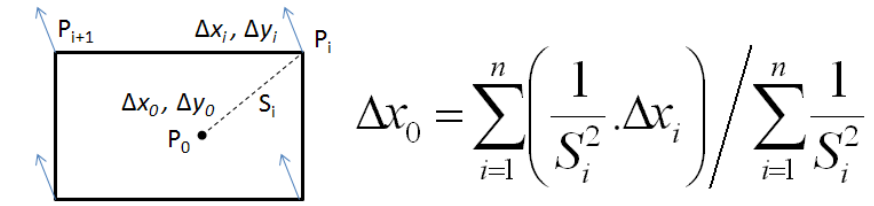
Figure 9. Computation of the contribution of displacement vectors in a given point P